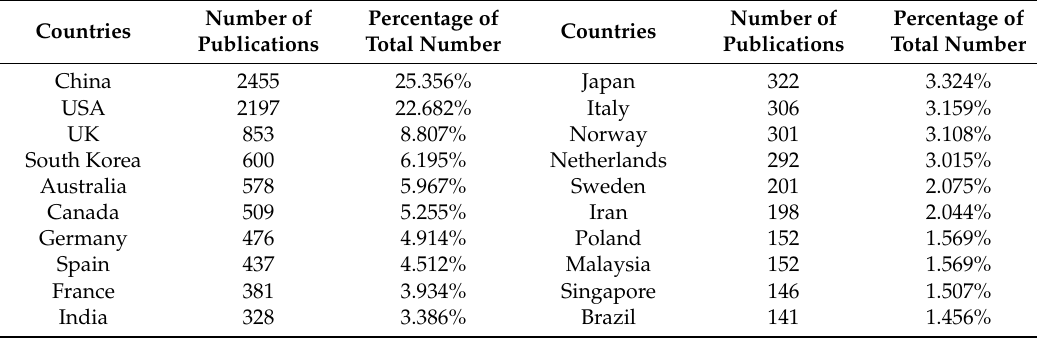
Table 1. Top 20 most productive countries in carbon capture and storage (CCS) research area. Countries